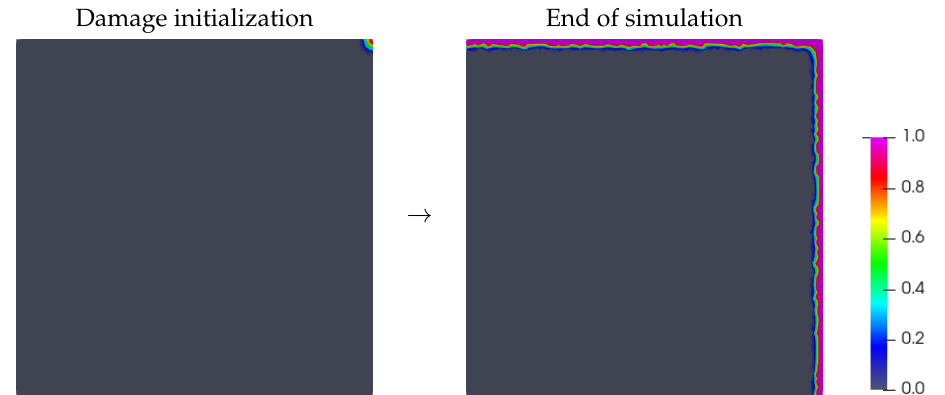
Figure 10. Damage evolution for single glass ply with static tensile strength.